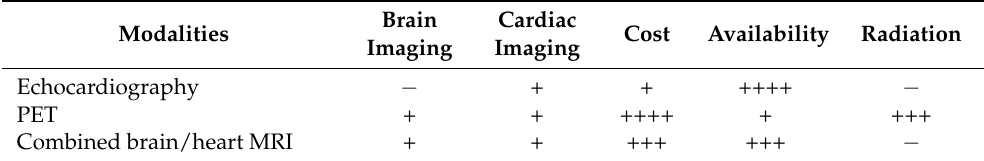
Table 1. Comparison of various imaging modalities for the evaluation of brain/heart interaction in heart